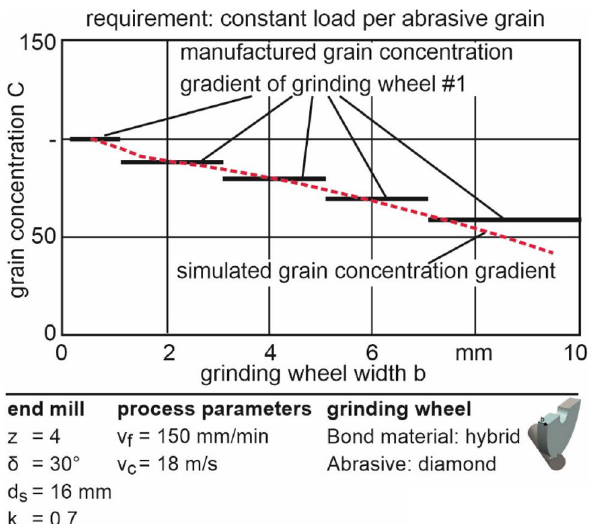
Fig. 5 Comparison between the manufactured and the simulated grain concentration curve